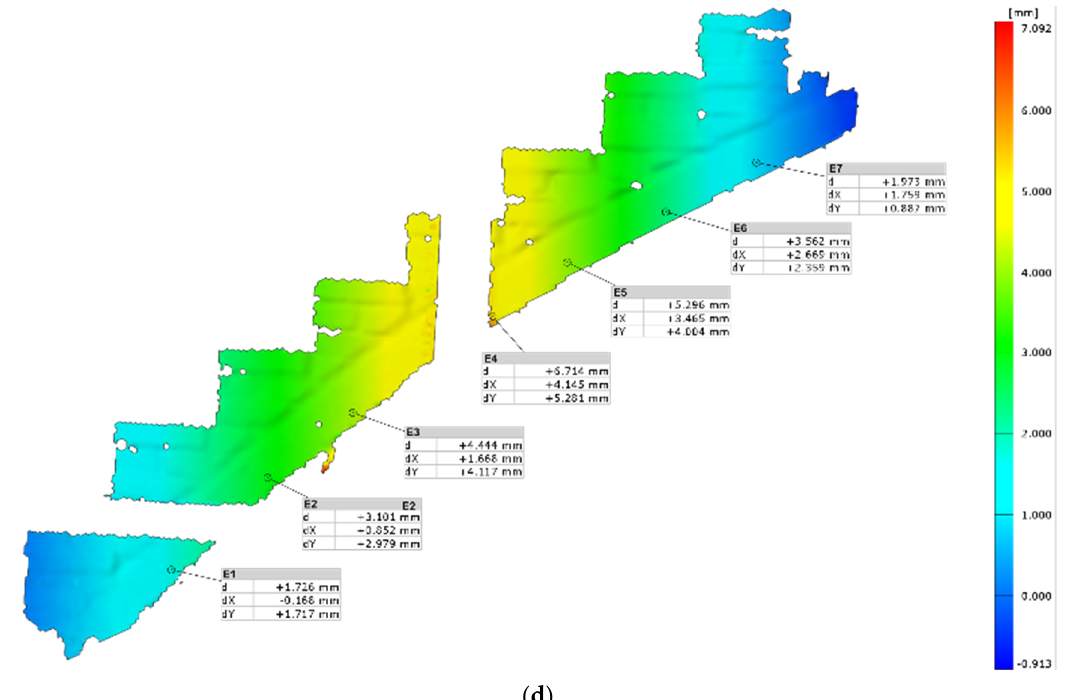
Figure 12. Results of experimental test of masonry staircases - displacement measured by ARAMIS: load P = 6 kN at point P 1 (bottom) ( a ), load P = 6 kN at point P 2 (middle) ( b ), load P = 6 kN at point P 3 (top) ( c ) and load at failure P = 59.8 kN in point P 2 ( d ). d - resultant displacement; dX - horizontal displacement; dY - vertical displacement.